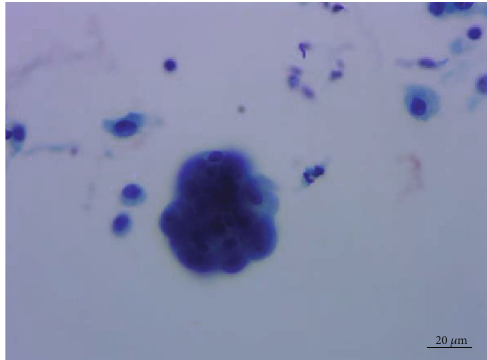
Figure 6: A small number of cell clusters showed three-dimensional spherical structure similar to adenocarcinoma cells. Pap staining, × 400.